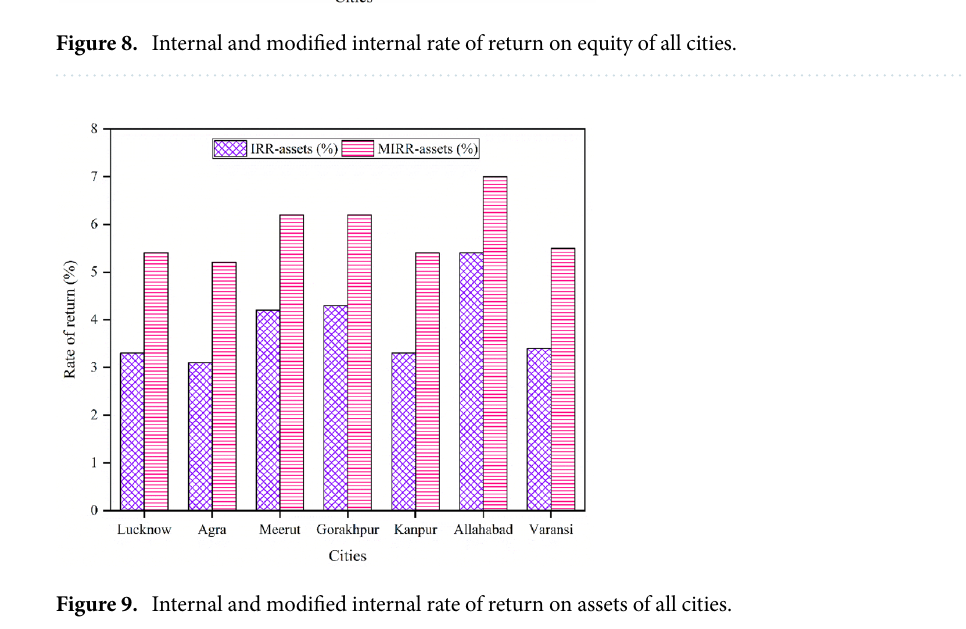
Figure 9. Internal and modified internal rate of return on assets of all